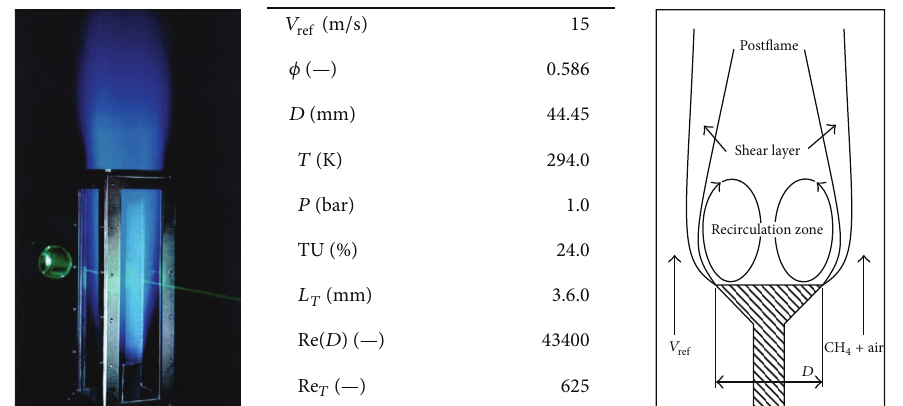
Figure 1: Vanderbilt combustor and reference conditions.